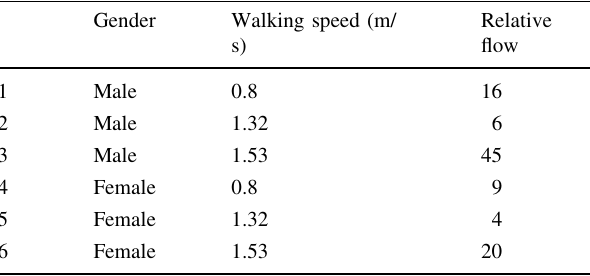
Table 3 Pedestrians movement speed in station